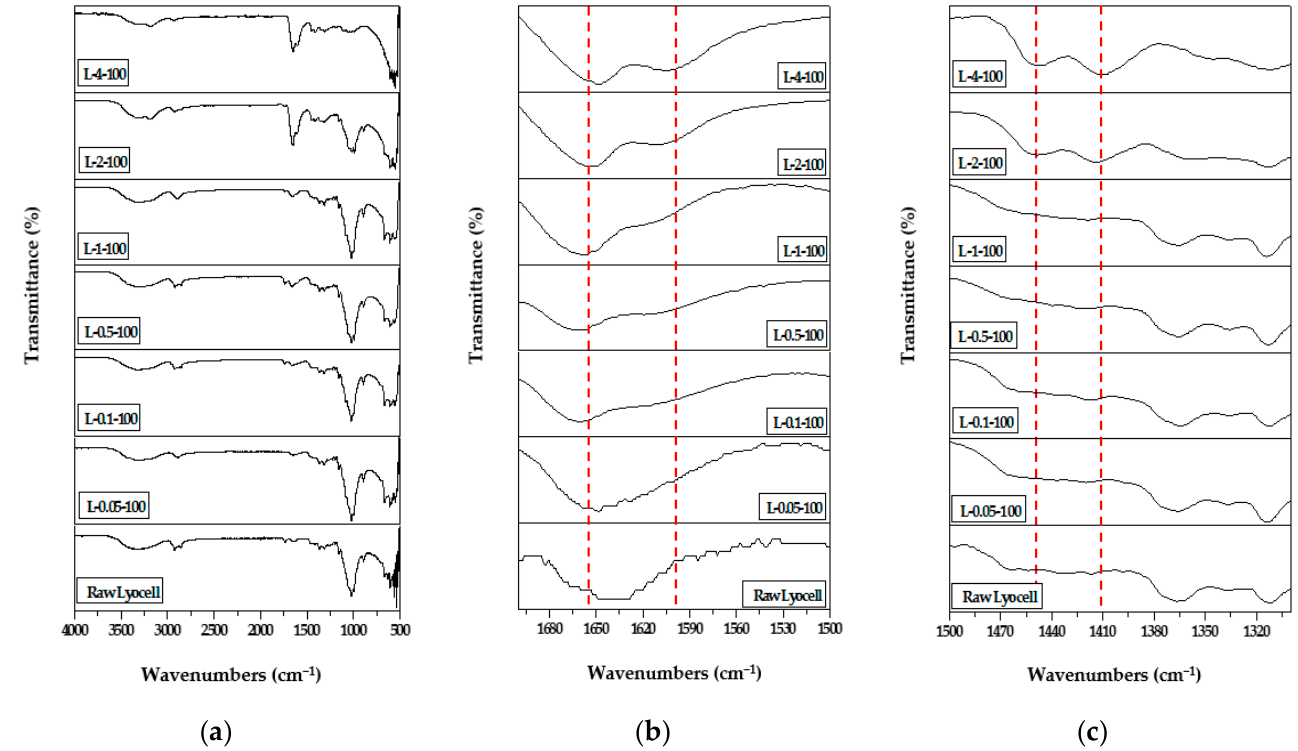
Figure 1. FT-IR spectra of raw lyocell fabric and lyocell fabrics (L-0.05-100, L-0.1-100, L-0.5-100, L-1-100, L-2-100, and L-4-100) grafted with different concentrations (0.05, 0.1, 0.5, 1, 2, and 4 wt.%) of PAM via 100 kGy of EBI dose in the range of ( a ) in the range of 500–4000, ( b ) 1700–1500, and ( c ) 1500–1300 cm − 1 . Table 1. XRD data corresponding to the carbon fibers obtained from lyocell fabrics grafted with PAM via EBI.